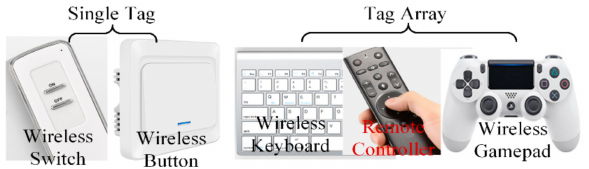
Figure 1. Potential applications of the proposed tag and tag array in smart homes and the